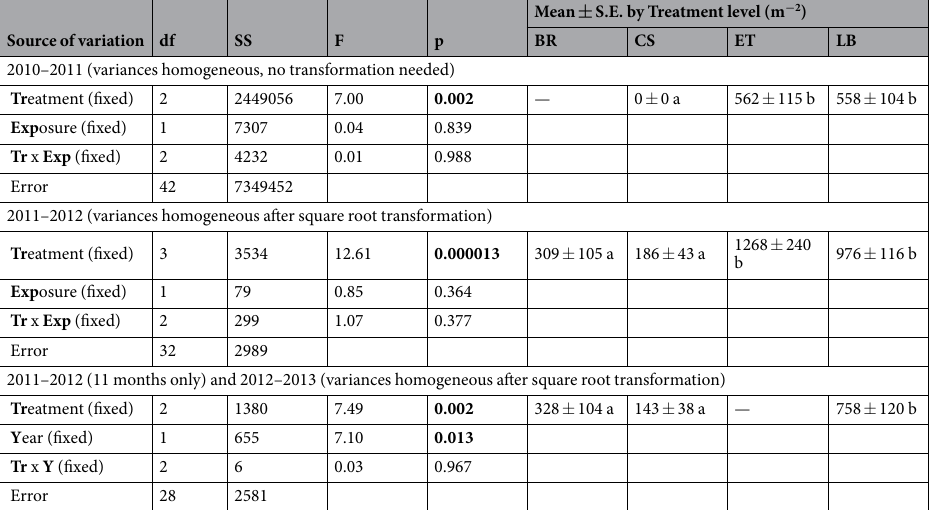
Table 1. Field substrate manipulation experiment: the results of ANOVA on abundances of solitary ascidians found on different substrates exposed for 2 and 11 months in 2010–2012, and for 11 months in 2012–2013. Densities per m 2 of substrate surface as a response variable. BR – Serripes shells with barnacles removed. CS – empty Serripes shells. ET – Serripes shells with empty barnacle tests. LB – Serripes shells with live barnacles. Ascidians found on Serripes shells in ET and LB treatments and on empty barnacle tests in LB treatments ignored. There were no ascidians on live barnacles in ET treatments. The results of Tukey HSD post-hoc tests are indicated by letters ‘a’ and ‘b’ following the means. Significantly (p < 0.05) different means have no letter in